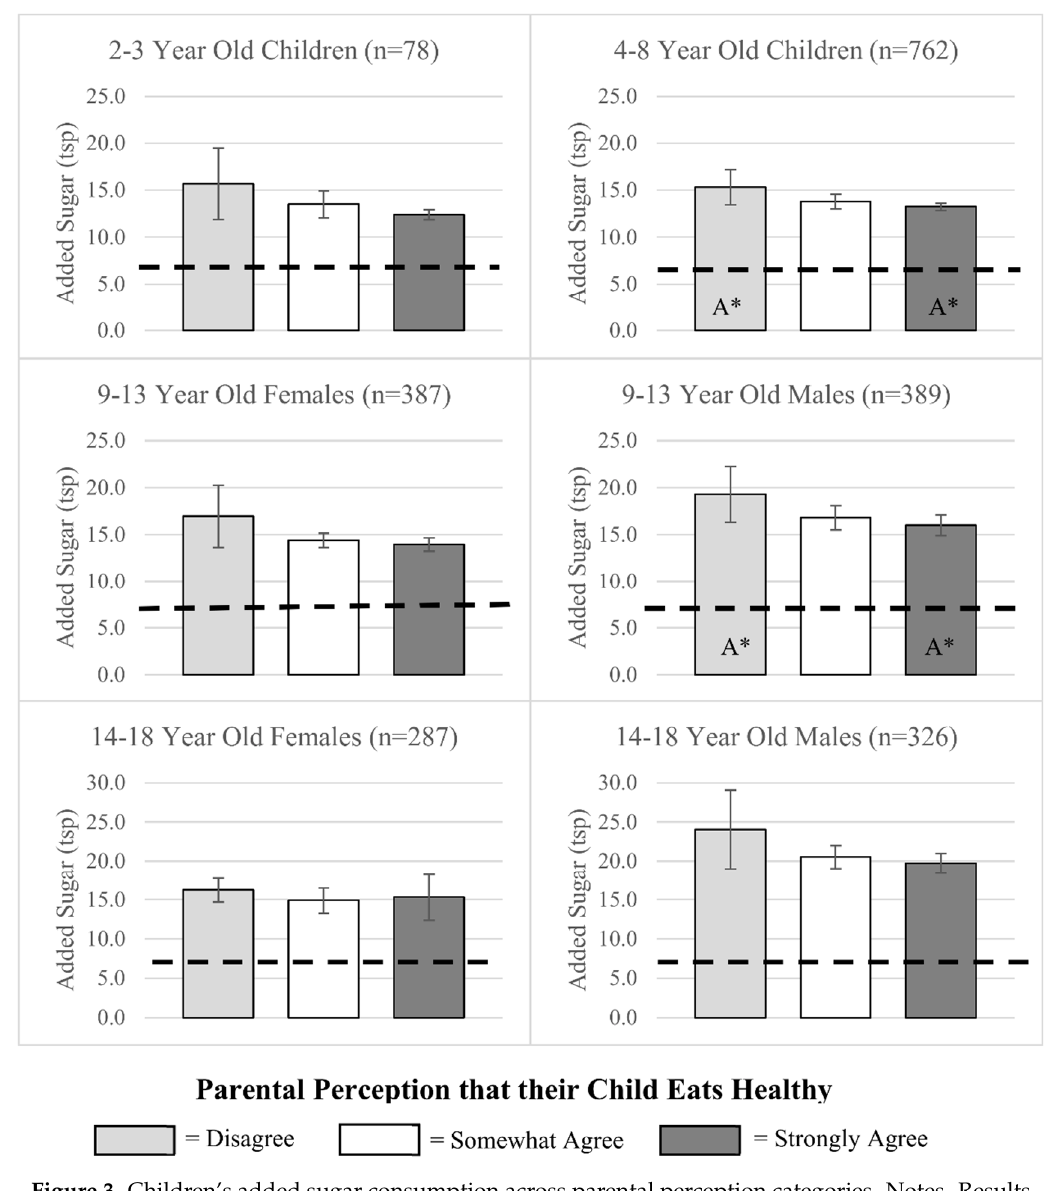
Figure 3. Children’s added sugar consumption across parental perception categories. Notes. Results from multivariate regression analysis showing adjusted average teaspoons of added sugars consumed by parental perception of children’s diet categories. Models included parental perception, sex, age, parental education, federal poverty level, race/ethnicity, SNAP participation, and WIC participation. Bars with the same letter (A, B, or C) represent significant differences in consumption across those perception categories (* p ≤ 0.05). American Heart Association recommendations for each age and sex category are represented by black dashed lines.